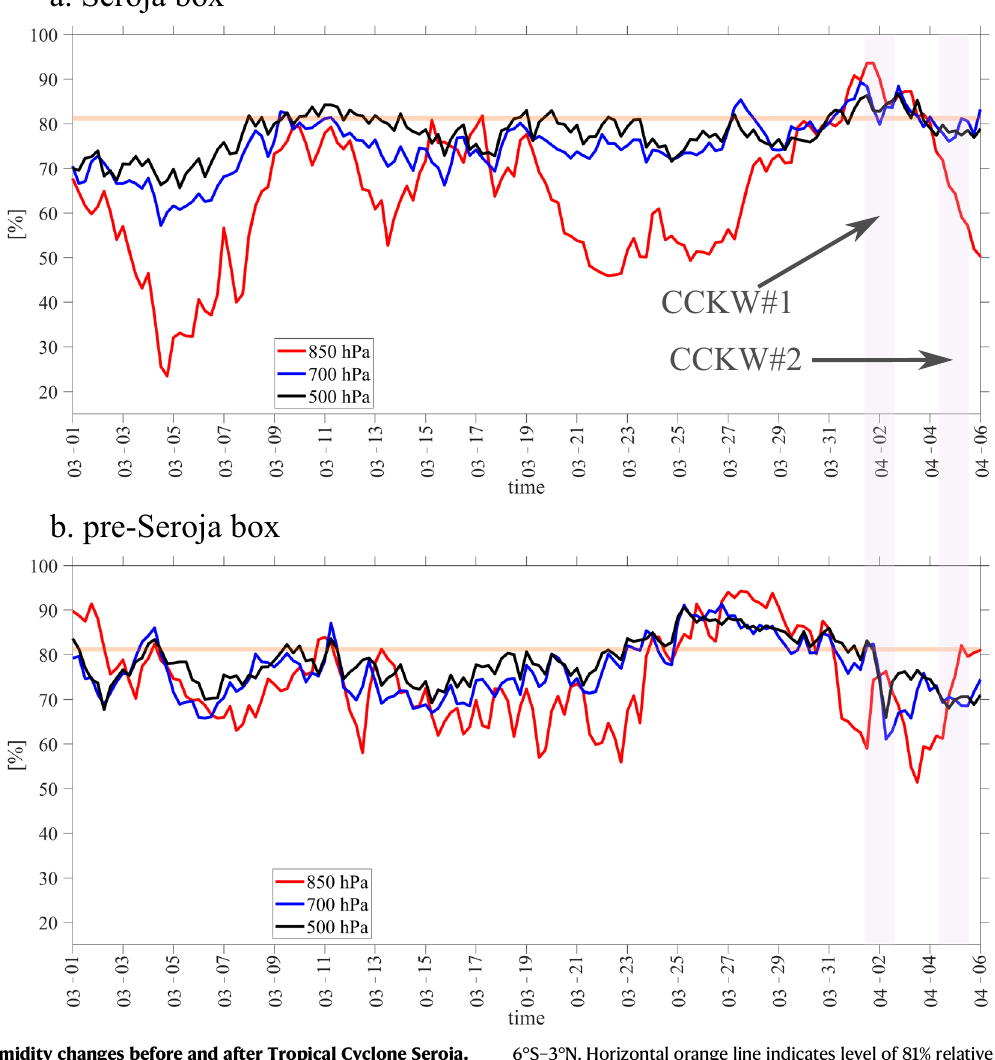
6°S – 3°N. Horizontal orange line indicates level of 81% relative humidity. Two pink boxes indicate periods of two sequential Convectively Coupled Kelvin Wave